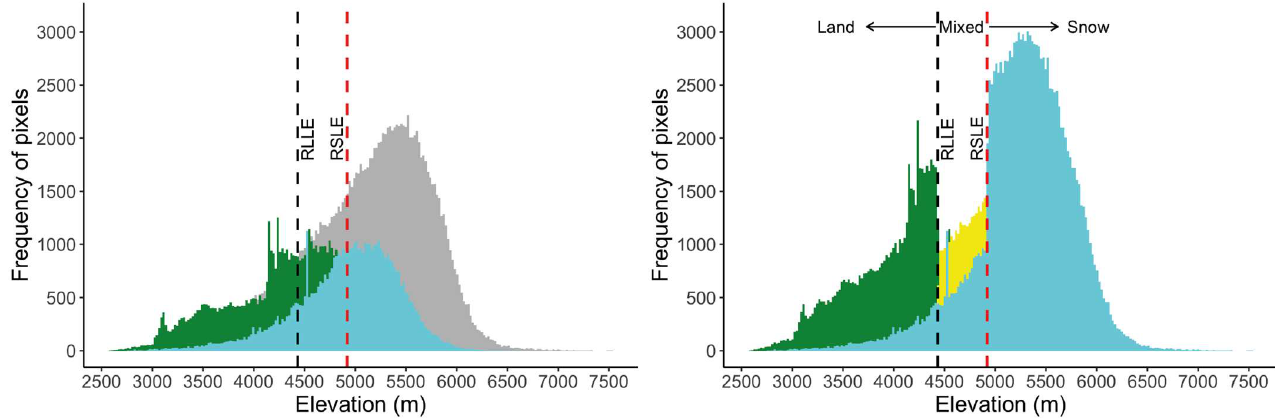
Figure 6. Number of land (green), snow (cyan), or cloud-covered (grey) pixels in relation to elevation (left) on a free temporal combination MODIS raster image on 16 January 2017. ( Right ): Spatio- temporal combination of MODIS image of 16 January 2017 after cloud reduction step 3. Cloud-covered pixels below RLLE (4433 m a.s.l.; black dashed line) are classified as land, between RSLE and RLLE (4919 m a.s.l.; red dashed line) as mixed pixels (yellow), and above RSLE as snow.